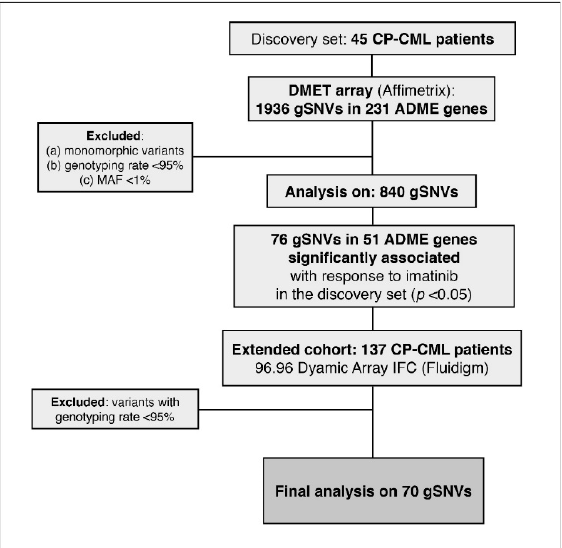
Figure 1. Flowchart describing genetic marker selection. ADME: adsorption, distribution, metabolism and excretion; MAF: minor allele frequency. gSNV: germline single ‐ nucleotide variant.